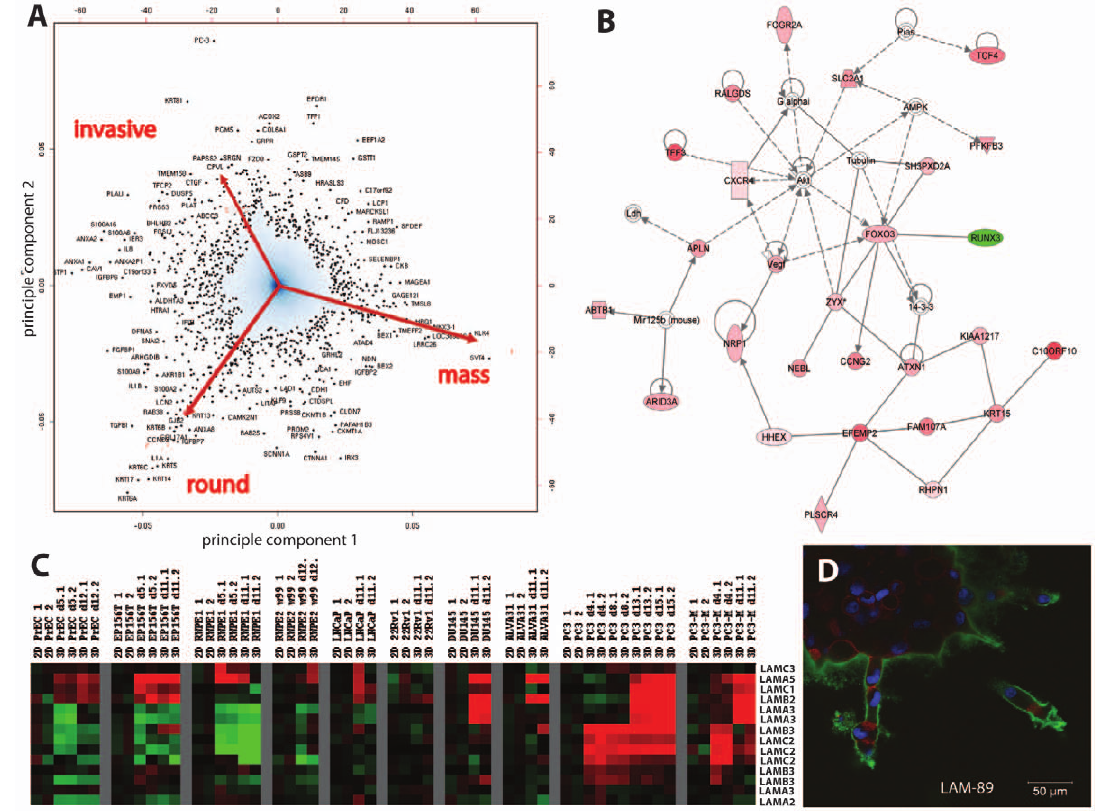
Figure 5. Functional analysis of altered gene expression data in 3D culture, compared to 2D monolayer. A) Principal component analysis (PCA), illustrating gene sets that distinguish round, mass-, and stellate morphologies. Round phenotype cells included were PrEC, EP156T, and RWPE1. The mass phenotype is represented by LNCaP and 22rV1 cells. Stellate/invasive cells comprise ALVA31, PC3, PC3M, and RWPE-2/w99. B) Ingenuity Pathway Analysis (IPA) of invasion-related clusters 9–12 (Figure 4), illustrating network 2 out of 13 generated. This network is centered on the AKT and PI3-Kinase pathways. Colors correlate to factors of differential expression observed between round and invasive spheroids (red: induced, green: repressed). C) Heatmap, illustrating altered mRNA expression of laminins in 2D and 3D culture. Expression of laminins a 5, c 1, b 2 and a 3 is strongly induced in the invasive transformation of PC-3 and PC-3M cells (days 13 + 15). D) Continuous expression of various laminins after onset of invasion, as demonstrated by staining with a human-specific antibody (LAM-89) that detects various alpha and beta